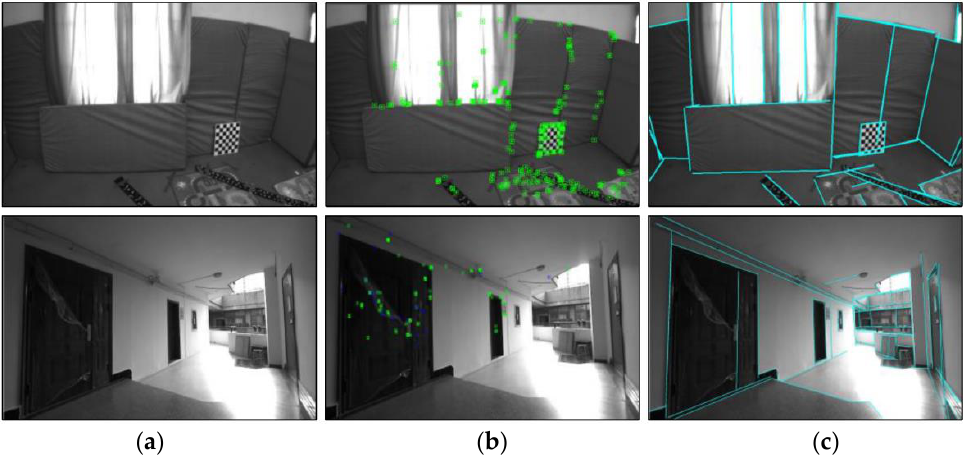
Figure 2. Results of the extracted point and line feature: ( a ) the original images; ( b ) the point feature detection results; ( c ) the line feature detection results.